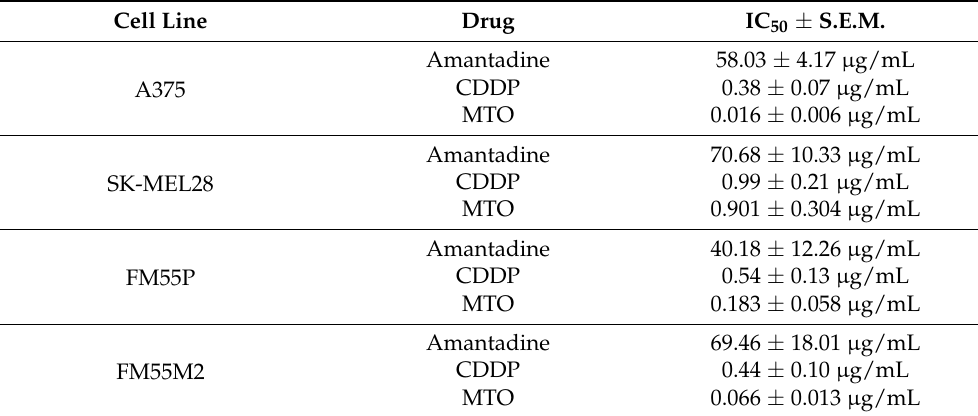
Figure 8. Concentration–response relationship curves (CRRCs) for mitoxantrone (MTO) and amantadine administered alone and in the combination at a fixed-ratio of 1:1, illustrating the anti-proliferative effects of the drugs in the human malignant melanoma cell lines (A375 ( A ), SK-MEL28 ( B ), FM55P ( C ) and FM55M2 ( D )) measured in vitro by the MTT assay. Table 1. Anti-viabilitive effects of amantadine, mitoxantrone (MTO) and cisplatin (CDDP) adminis- trated separately in melanoma cell lines (A375, SK-MEL28, FM55P and FM5M2) measured in vitro by means of MTT